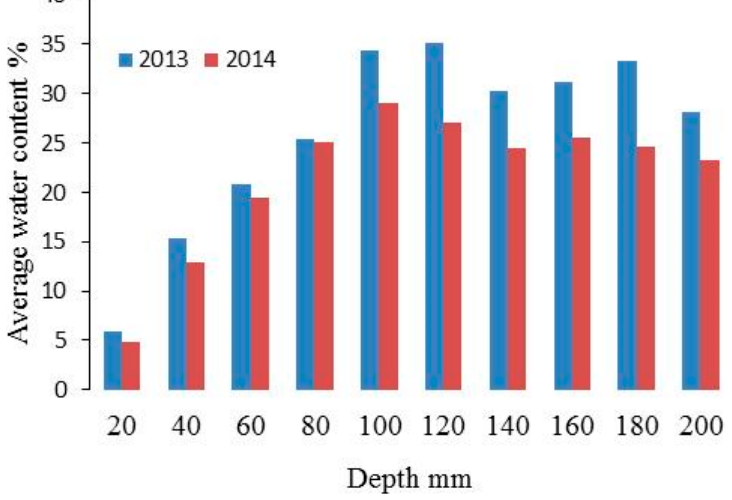
Figure 1. Gravimetric soil water content at the time of testing in experiments: for 2013 and 2014.